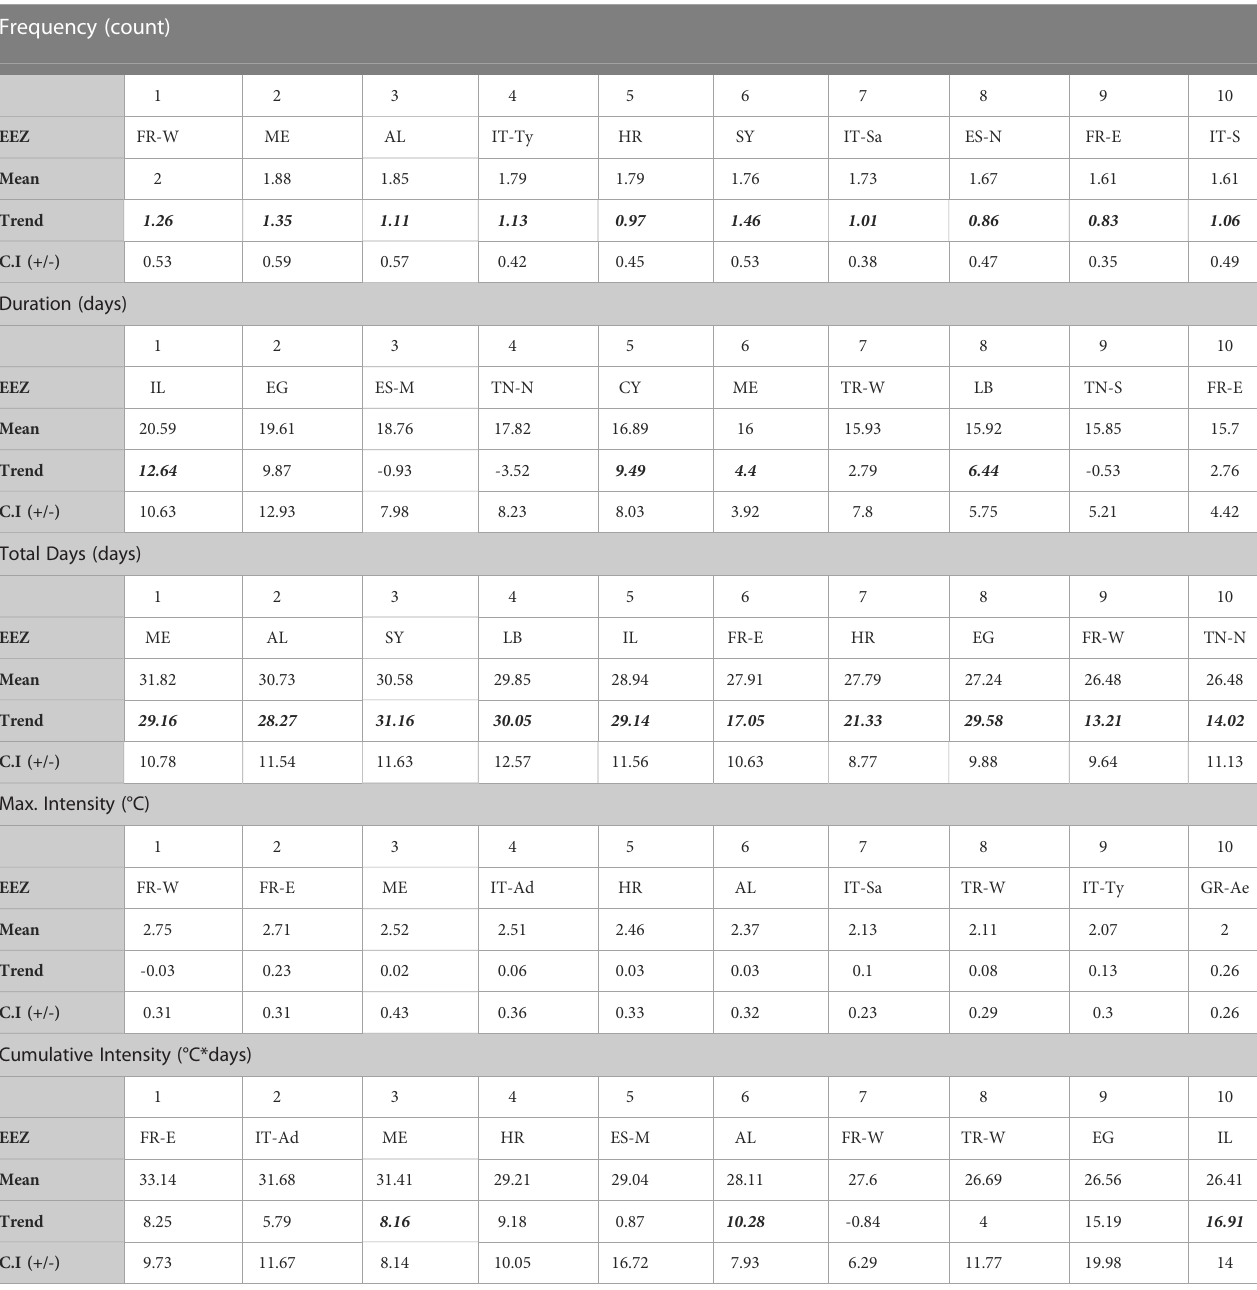
TABLE 2 Mean and trend for surface (SST) MHW characteristics in EEZ areas (as displayed in Figure 1 ). Frequency